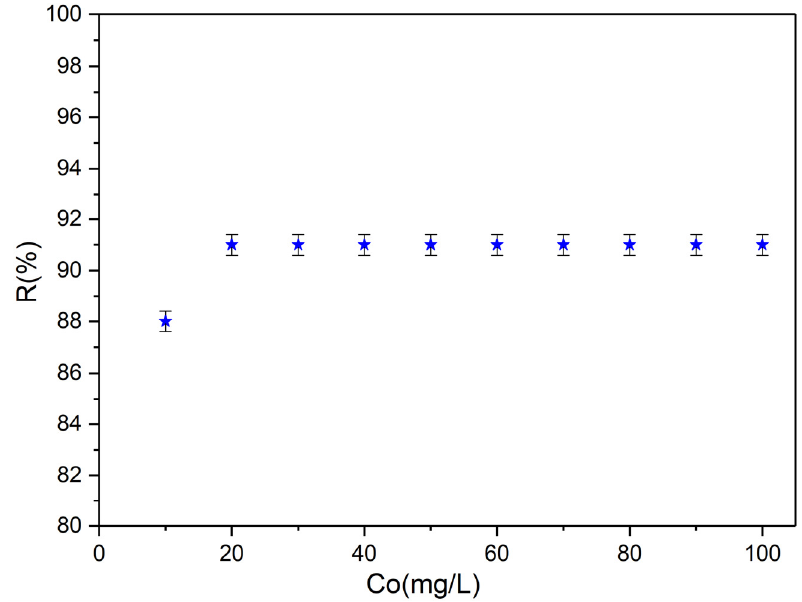
Figure 6. The removal percentage of Sr 2+ ions from contaminated aqueous solutions using HAp nanoparticles.